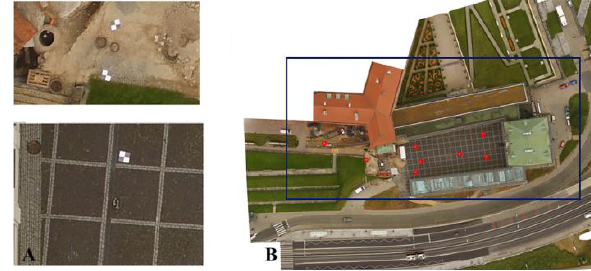
Figure 2. The ground control points on tested area. A) The example of the used target, B) The sketch of distributed ground